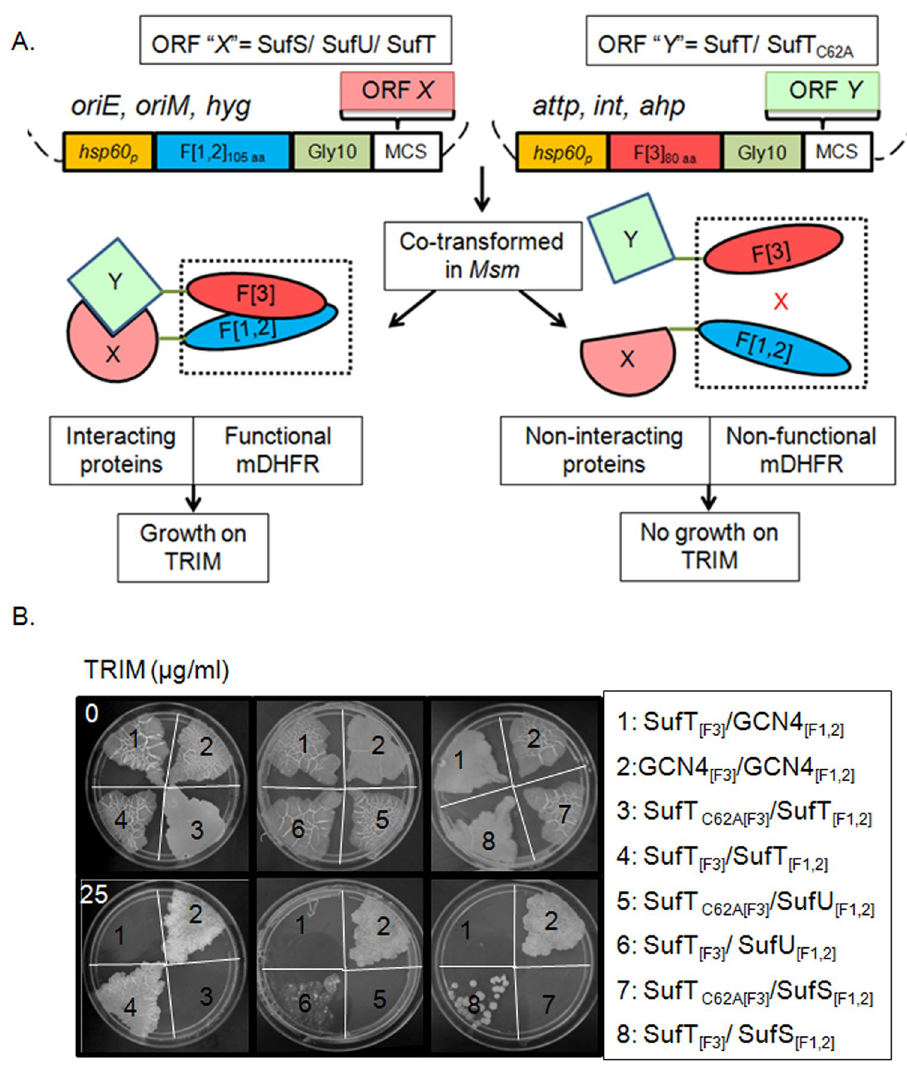
Fig 2. SufT interacts with SufS and SufU of SUF system. (A) Model illustrating the principle of M-PFC. Two independent plasmid constructs for candidate proteins X and Y are shown in fusion to complementary mDHFR fragments F [1, 2] and F [3], respectively. Co-transformation of XF [1, 2] and YF [3] fusions in Msm results in the functional reconstitution of mDHFR activity and subsequent growth on TRIM (0 and 25 μ g/mL; concentration) plates, whereas proteins that do not interact will not reconstitute F [1, 2] and F [3] and consequently no growth on TRIM plates. Components of vectors, aph confers resistance to KAN; hyg confers resistance to HYG; hsp60p is the hsp60 promoter; oriM is the origin of replication for propagation in mycobacteria; oriE is the origin of replication for propagation in E . coli ; and int and attP are the integrase and phage attachment sites, respectively, from mycobacteriophage L5. (B) M-PFC based demonstration of C62 dependent specific protein-protein interaction of SufT with SufT, SufU and SufS. Msm as a host was co-transformed with plasmid construct expressing 1) SufT [F3] /GCN4 [F1,2] (negative control), 2) GCN4 [F1,2] /GCN4 [F3] (positive control), 3) SufT C62A[F3] /SufT [F1,2] , 4) SufT [F3] /SufT [F1,2], 5) SufT C62A[F3] /SufU [F1,2] , 6) SufT [F3] /SufU [F1,2] , 7) SufT C62A[F3] /SufS [F1,2] and 8) SufT [F3] /SufS [F1,2]. M-PFC experiments were repeated thrice, one representative image is shown